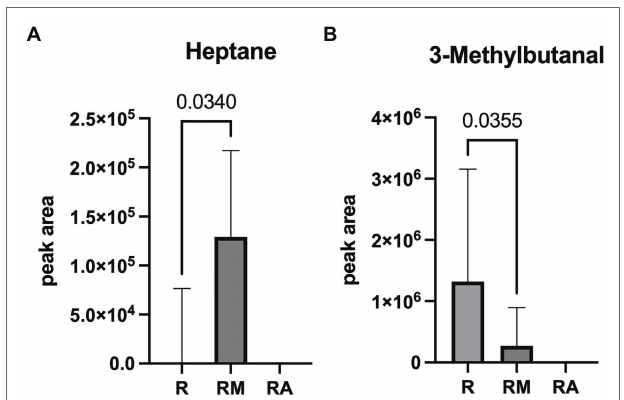
FIGURE 5 | Heptane (A) and 3-Methylbutanal (B) as volatile organic compounds (VOCs) with significant group difference. R, reuterin supernatant (reuterin group); RM, biotransformation medium (reuterin medium group); RA, room air